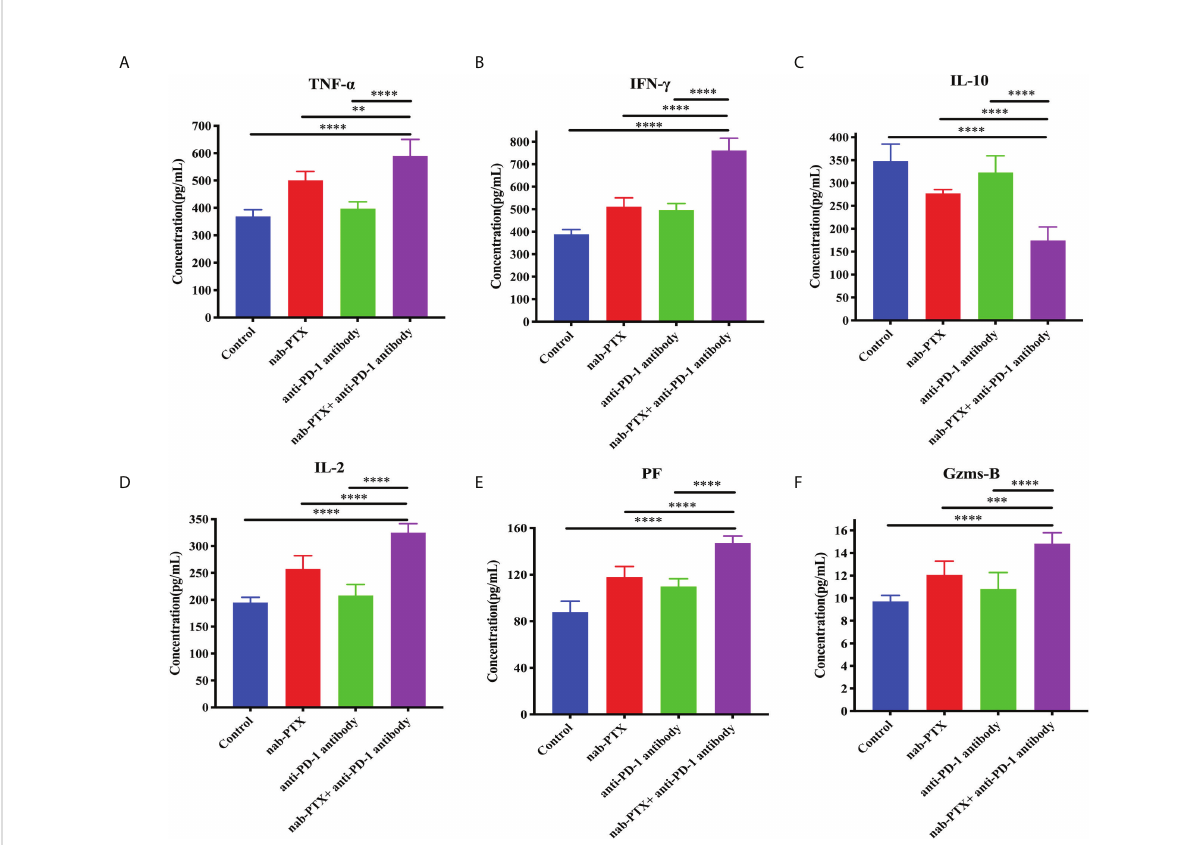
FIGURE 4 Concentrations of (A) TNF- a , (B) IFN- g , (C) IL-10, (D) IL-2, (E) PF, and (F) Gzms-B in the tumor microenvironment with the administration of nab-PTX and anti-PD-1 antibody ( n = 3, biological duplicates). TNF- a , tumor necrosis factor a ; IFN- g , interferon-gamma; IL-10, interleukin 10; IL-2, interleukin 2; PF, perforin; Gzms-B, granzymes B. The data were from three independent biological replicates with one-way ANOVA followed by Tukey ’ s multiple comparisons. ** p < 0.01, *** p < 0.001, **** p <